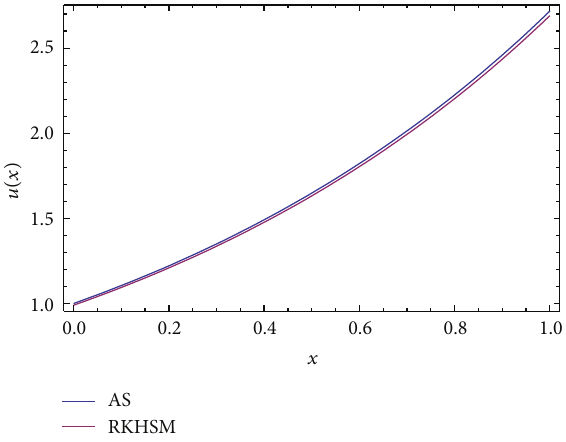
Figure 1: Comparison of analytical solution and RKHSM solution for Example 10.